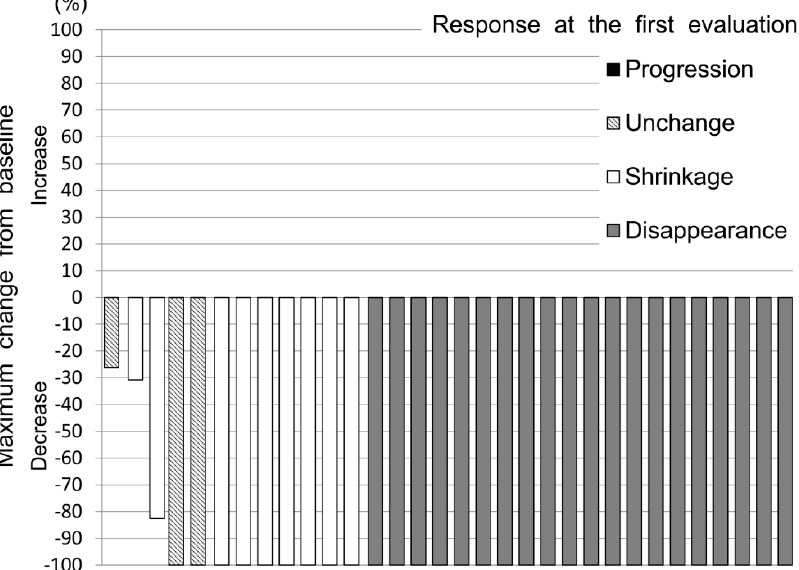
Figure 4. Waterfall plot of confirmed maximum change from baseline.